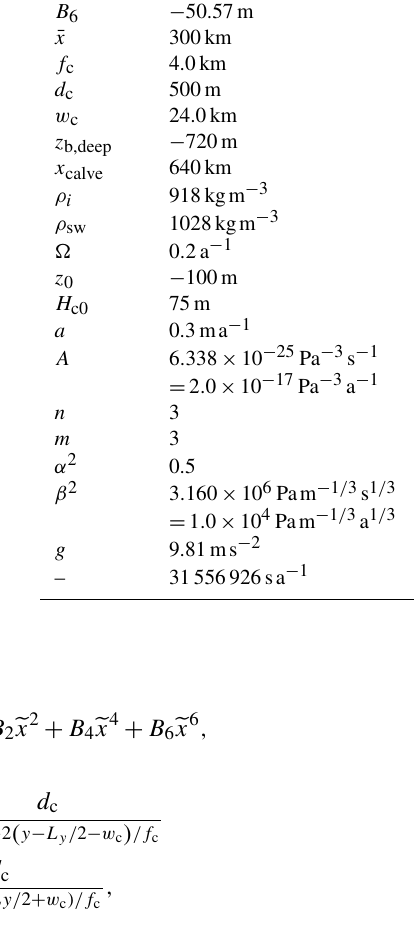
Characteristic along-flow length scale of the bedrock Depth of the trough compared with the side walls